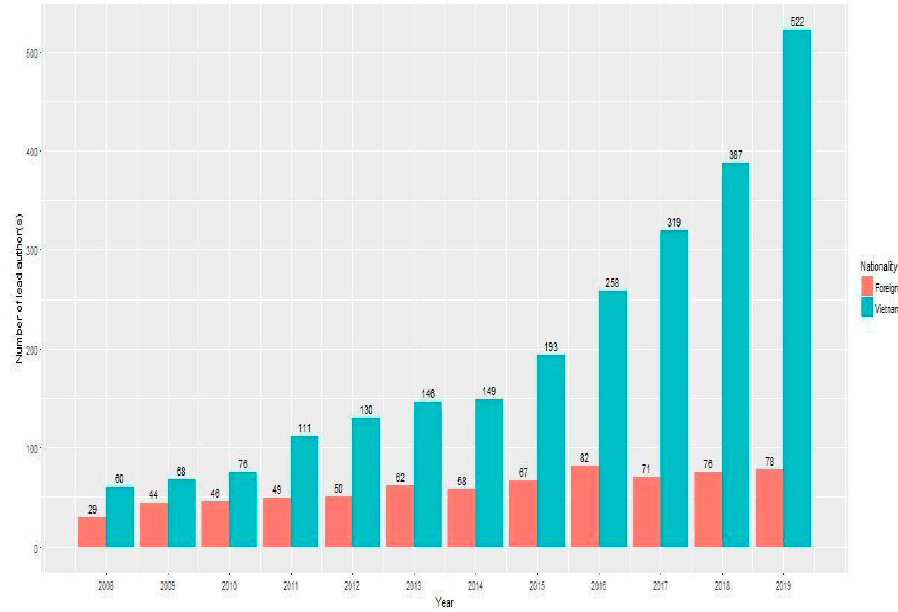
Figure 1. The number of Vietnamese and foreign lead authors in SSH research during 2008–2019 (last updated 30 April 2020).